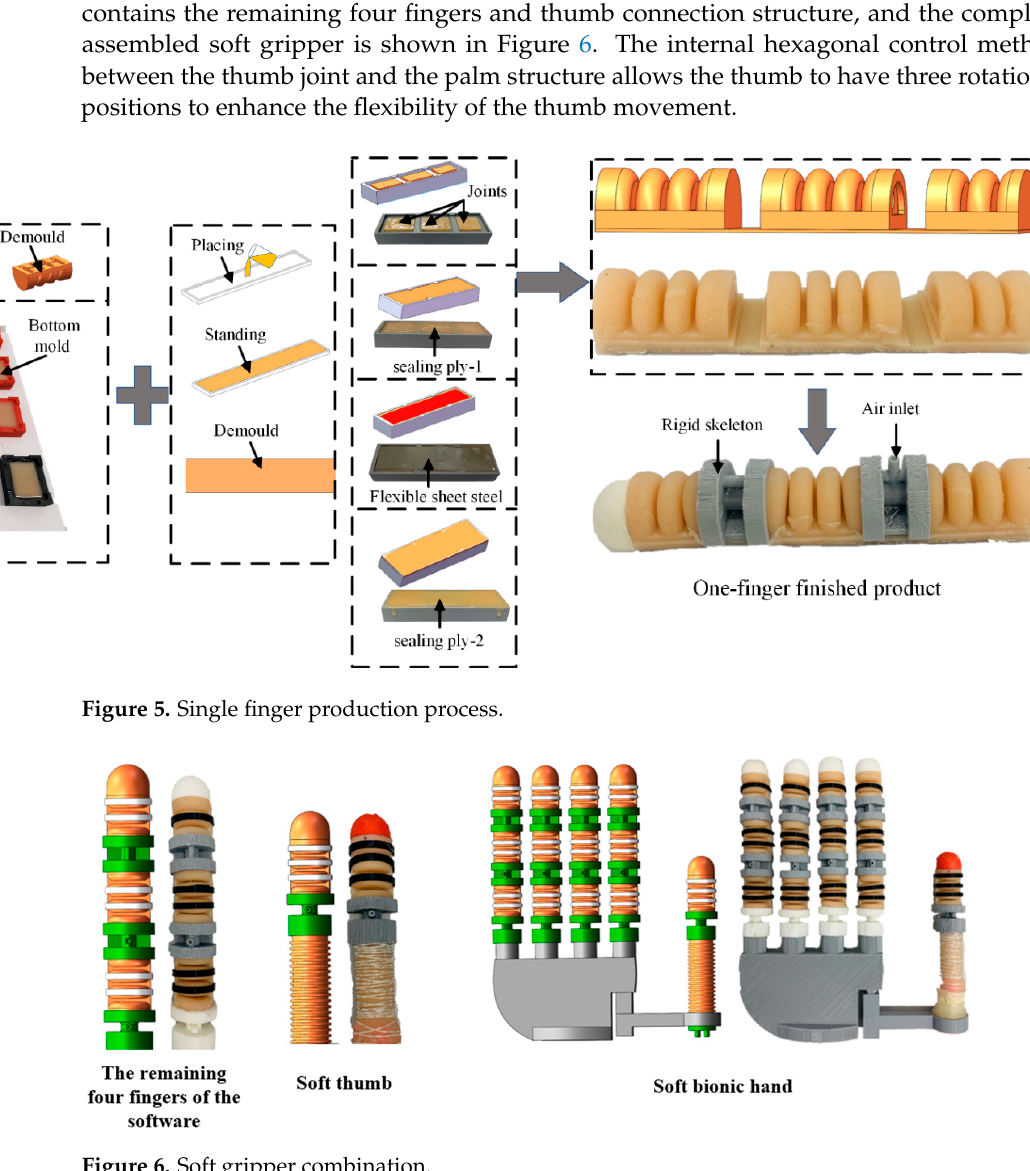
Figure 6. Soft gripper combination.